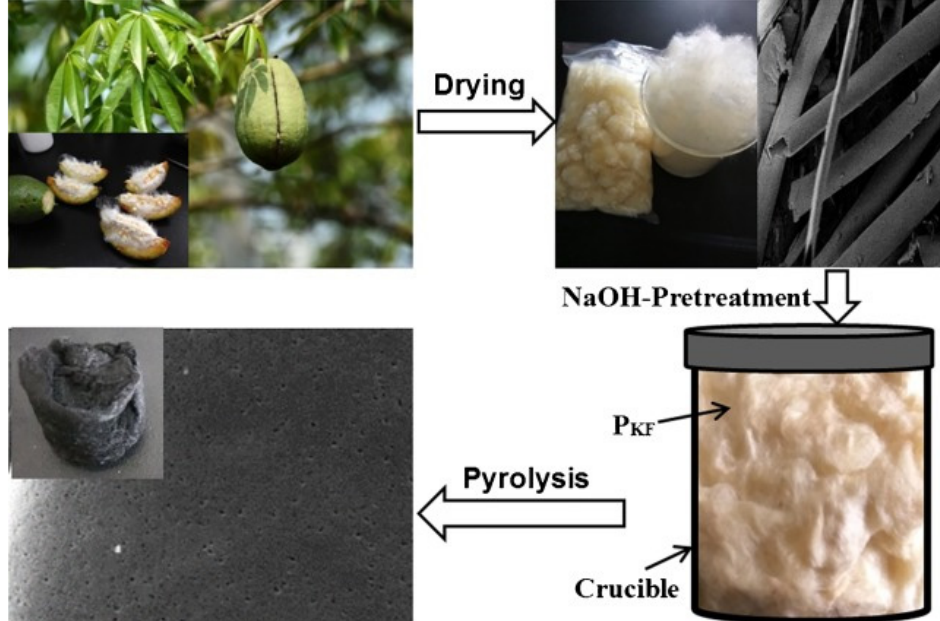
Figure 8. Representation of a pyrolysis Kapok Fiber processing methodology. Reprinted with permission from Ref. [90]. Copyright 2018, copyright Elsevier.